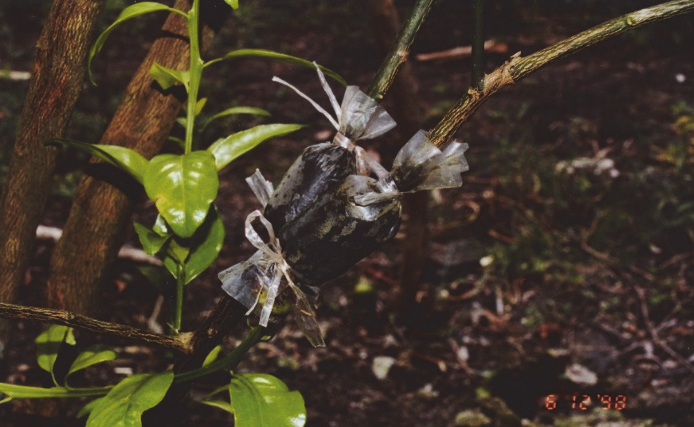
Figure 1. Marcotted seedlings from HLB ‐ infected tree.